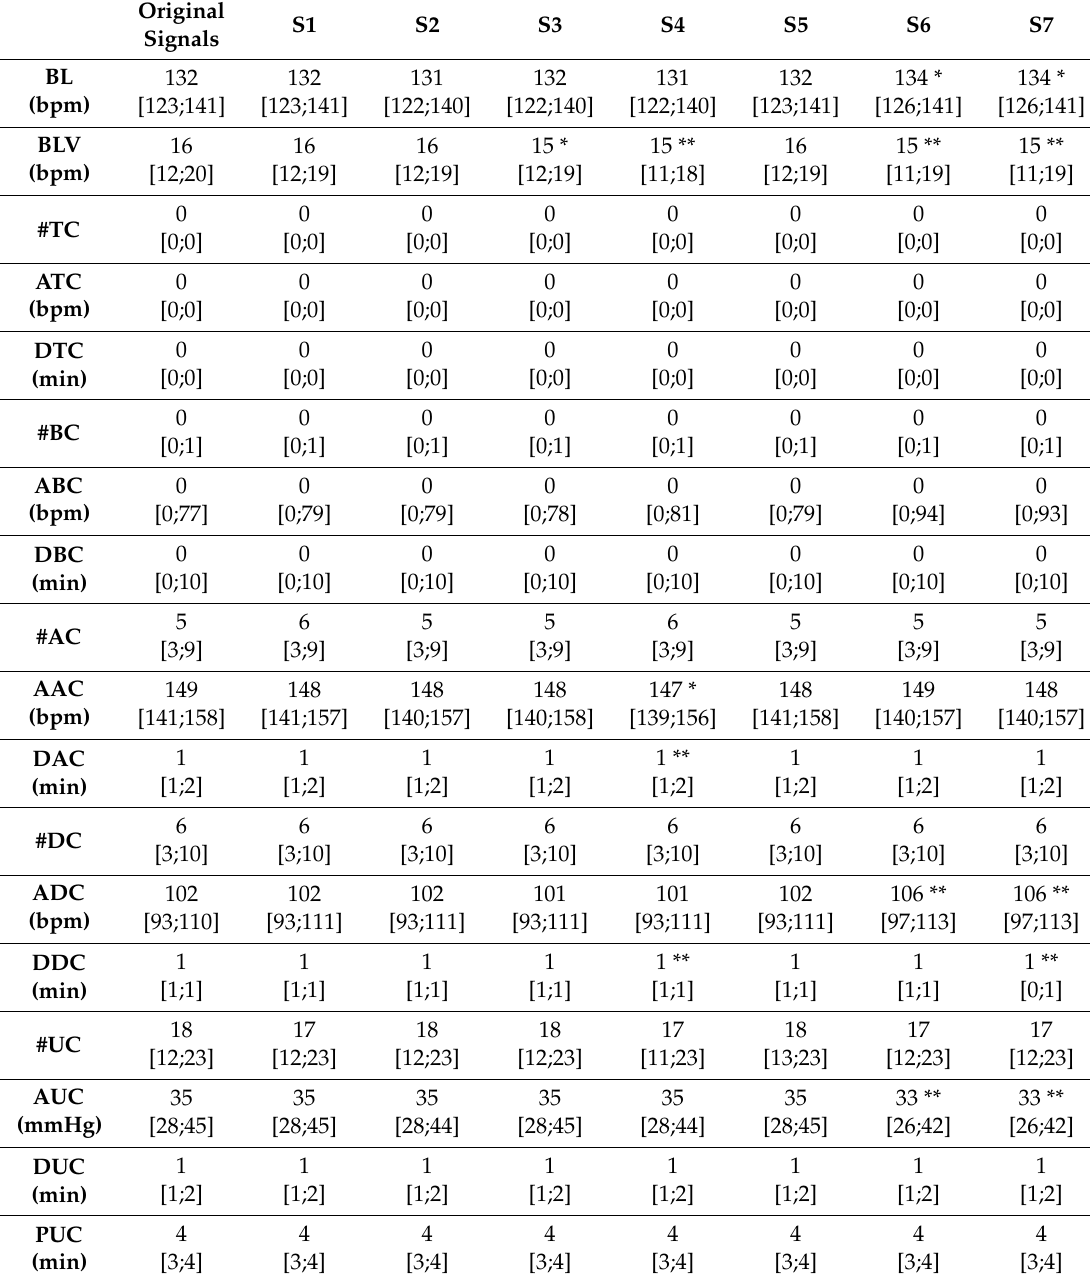
Table 3. Clinical variables distribution of all CTG signals extracted by eCTG. Non-normal distributions are reported in terms of 50th[25th;75th]